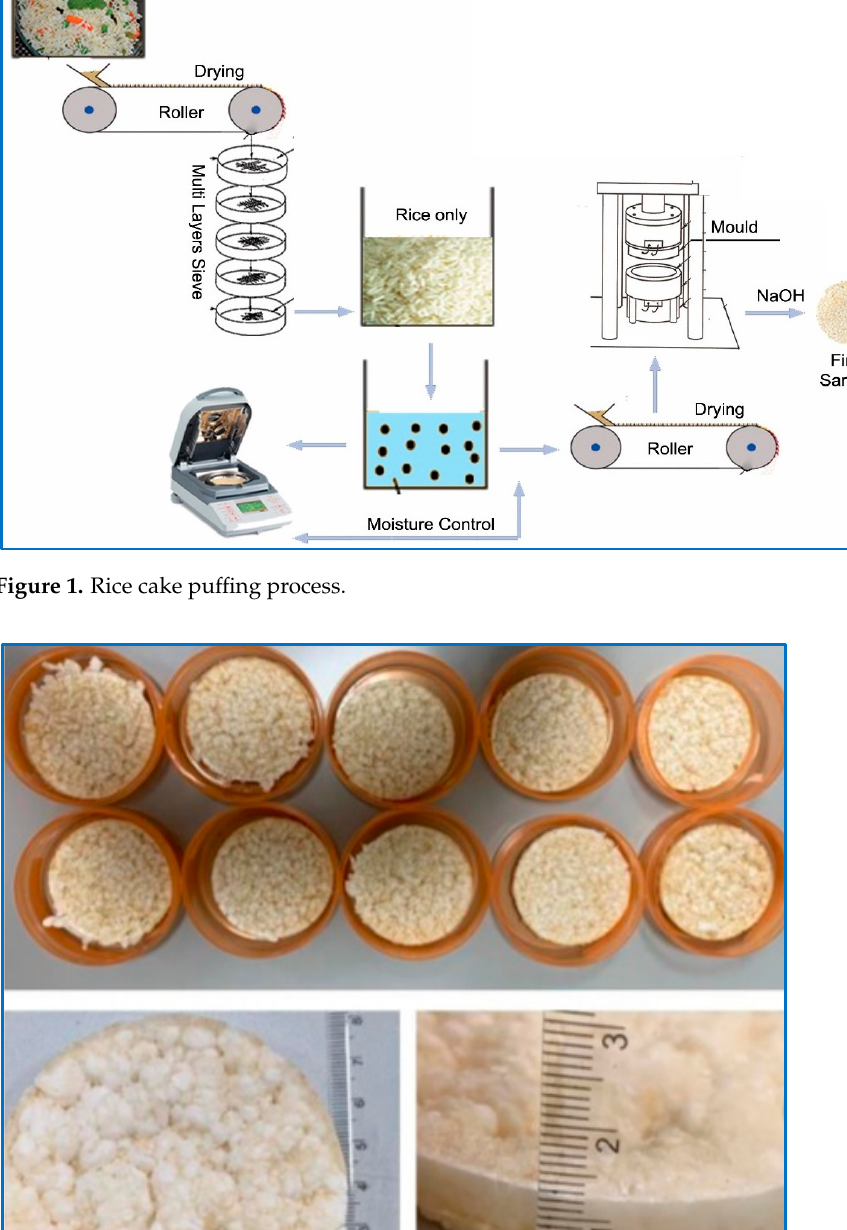
Figure 2. Final produced samples size, shape, and thickness.